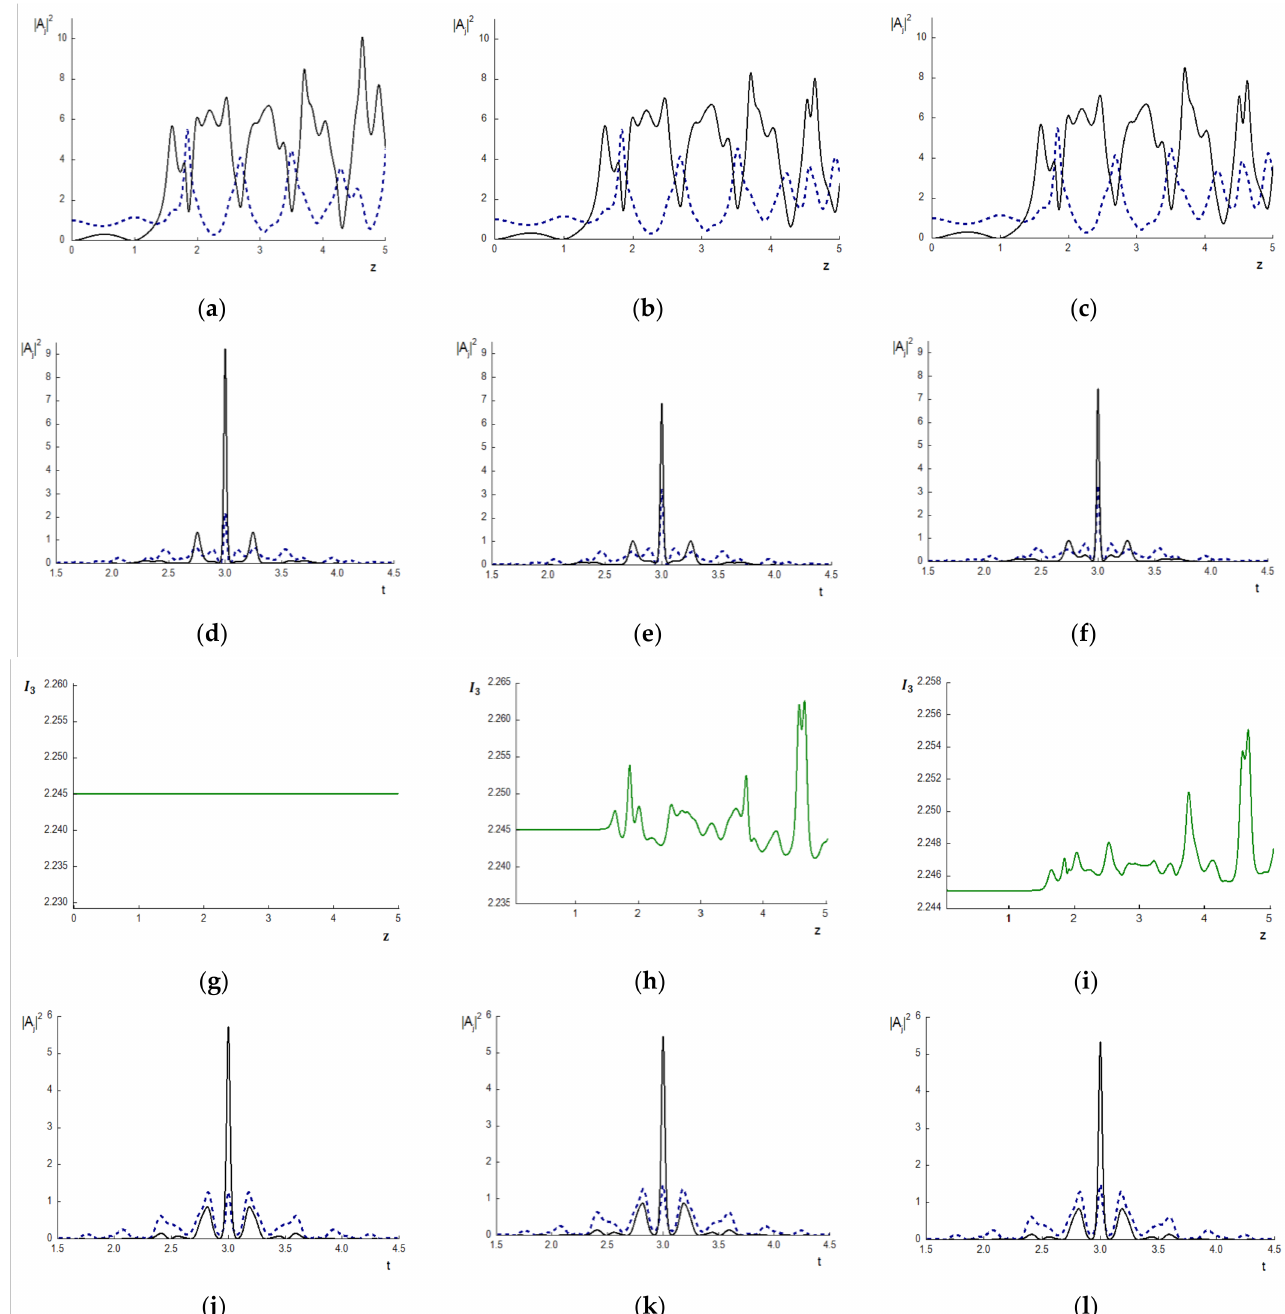
Figure 6. The intensity evolution at the pulse center ( a – c ) and pulse shapes in sections z = 4.6 ( d – f ), 4 ( j – l ) for the BW (dashed line) and the TH wave (solid line), the Hamiltonian deviation ( g – i ) computed using the CFDS-I3 ( a , d , g , j ), ISSM ( b , e , h , k ), and SSMRK ( c , f , i , l ),